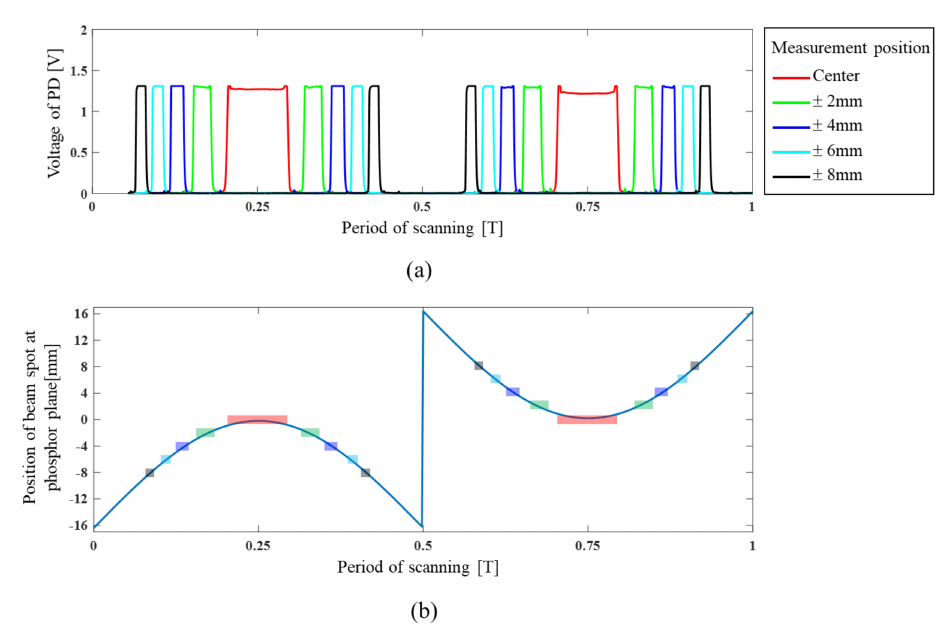
Figure 9. ( a ) Measured voltage by photodiode (PD) at phosphor plane in designed scanning sys- tem. ( b ) Position of beam spot at phosphor plane according to period of scanning in designed scanning system.